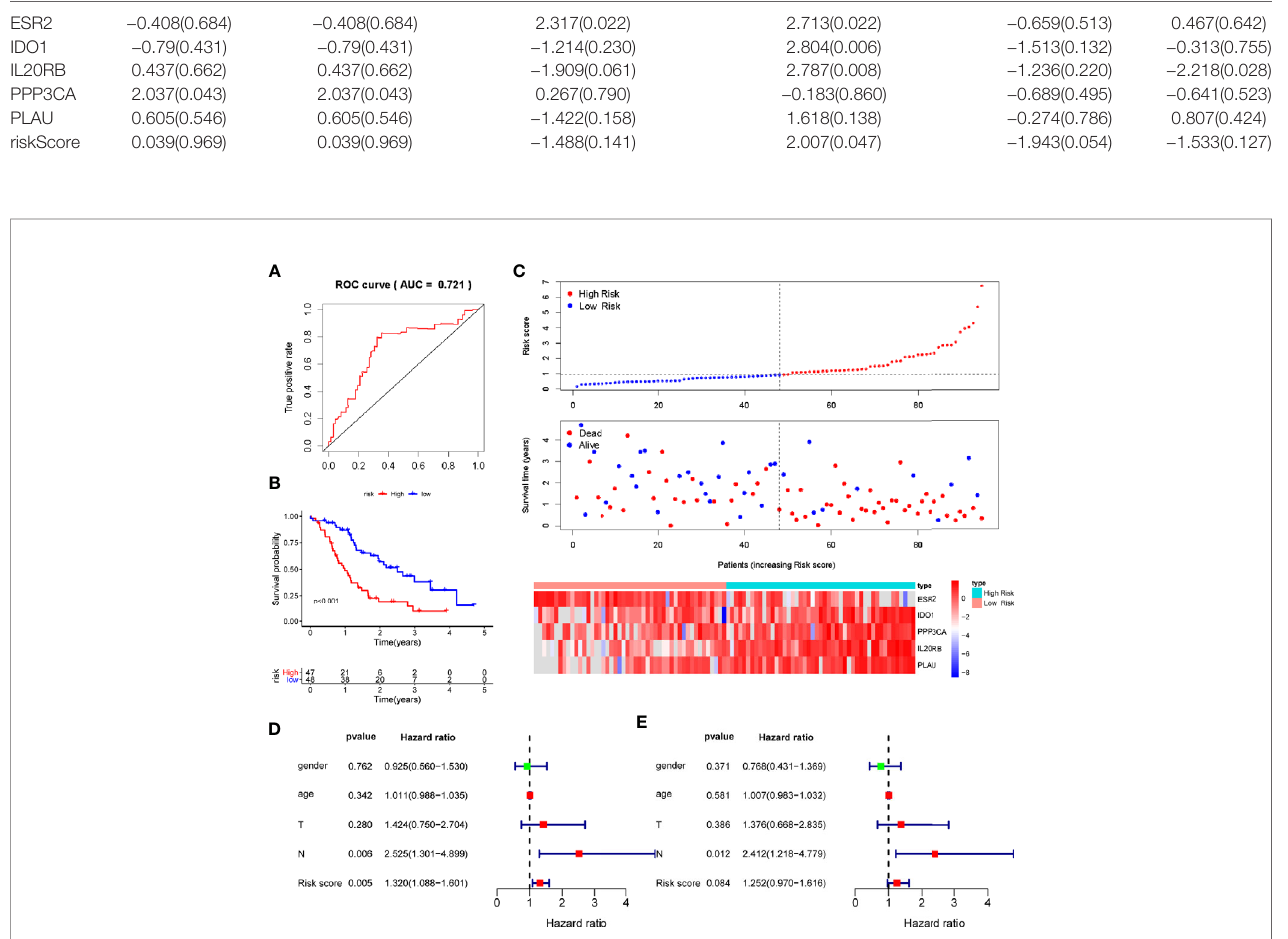
FIGURE 3 | Validation of prognosis-associated immune signature (PAIS) for pancreatic ductal adenocarcinoma (PDAC) in the test cohort. (A) ROC curve analysis of the PAIS for overall survival (OS). (B) Kaplan-Meier survival curves of OS for patients with stages of PDAC based on PAIS. (C) Heatmap of 5-gene expression pro fi les, PAIS distributions, and live status of each patient in the high- and low-risk sets. (D, E) Univariate (D) and multivariate (E) Cox regression analyses of the associations between PAIS and clinical variables for the predictive value of